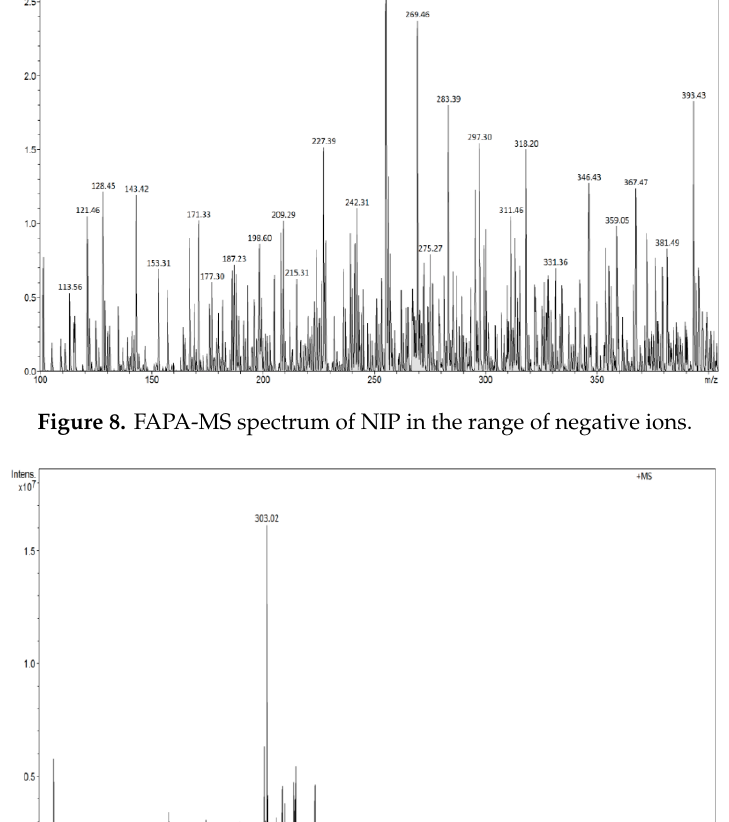
Figure 7. FAPA-MS spectrum of NIP in the range of positive ions.